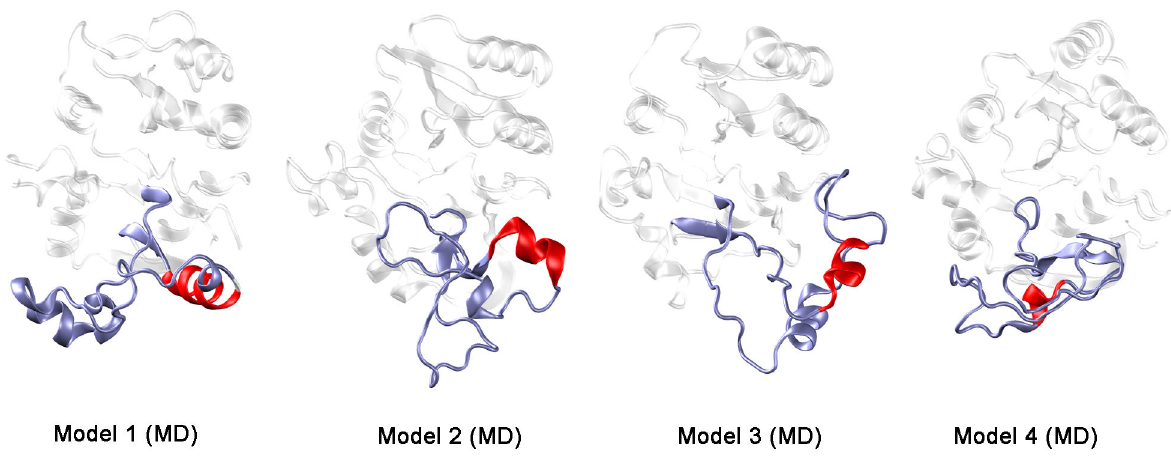
Figure 7. MG517 structural models after MD simulations. The variable region is highlighted, with the converged α-helix in red. doi: